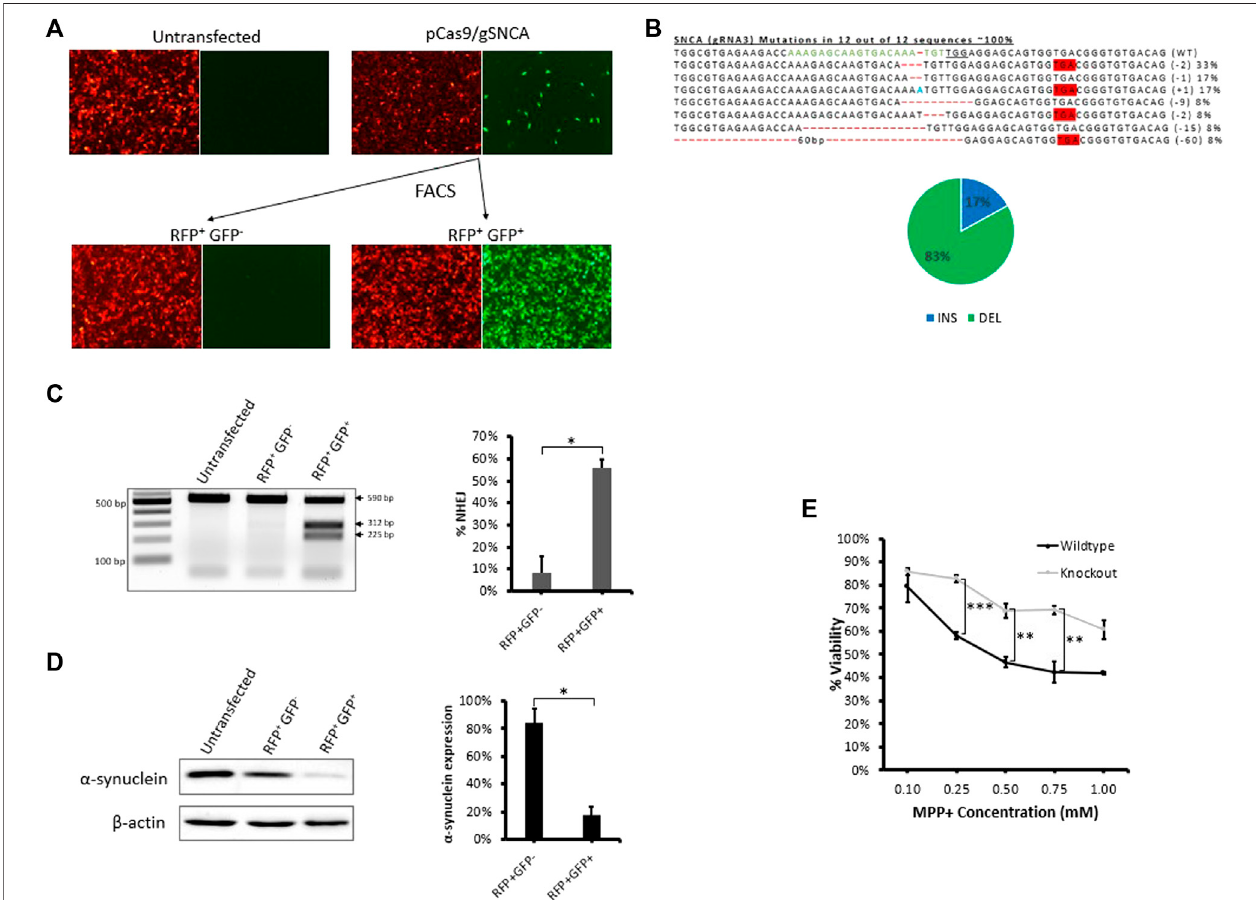
FIGURE 5 | Fluorescence assisted enrichment of knock-out SH-SY5Y cells. (A) Microscopy images of pre- and post-sorted fl uorescent reporter SH-SY5Y cells transfected with plasmid targeting SNCA gene. (B) Sanger ’ s sequencing of clones revealing CRISPR-induced indels and mutations. gRNA binding site (green) in the wildtype (WT) sequence is shown, the PAM sequence is underlined, dashes indicate deletions (-), nucleotides colored in blue indicate additions (+), and nucleotide colored in red indicate substitutions (s). Mutation frequencies (shown on the right) are calculated as the number of clones carrying a mutation divided by the total numberofclonessequenced.Mutationfrequenciesareillustratedinthepiechart:atotalof17%ofthemutationsleadtoinsertions,33%leadtodeletions,and67%lead to the formation of a premature stop codon. (C) T7E1 assay carried out on genomic DNA extracted from post-sorted RFP + GFP- and RFP + GFP + cells con fi rming the formation of indels in the target region. Quanti fi cation of indels in T7E1 is shown on the right. Values were background corrected from Untransfected group. Results are expressedasmean±standarderrorofthemeanof n =3fromT7E1assaycarriedoutongenomicDNAoftargetedcells.Therewasasigni fi cantdifferenceinfrequencyof indels (*, p < 0.05) between RFP + GFP − and RFP + GFP + groups, as analyzed by Student ’ s t -test. (D) Western blot evaluation of endogenous α -synuclein protein expression in post-sorted RFP + GFP − and RFP + GFP + cells. Quanti fi cation of protein expression in western blot is shown on the right. Results are expressed as mean ± standard error of the mean of n = 3 blots carried out on cell lysates of the same cells. There was a signi fi cant difference in protein expression (*, p < 0.05) between RFP + GFP − andRFP + GFP + groups,asanalyzedbyStudent ’ s t -test. (E) CytotoxicityMTTAssaycomparingcellularviabilityofSNCAwildtypereporterSH-SY5Ycellsand RFP + GFP + SNCA knock-out cells exposed to 1, 2.5, and 5 mM MPP + for 24 h. Results are expressed as mean ± standard error of the mean of n = 3. There was a signi fi cantdifferenceincellularviability(**, p < 0.01;***, p < 0.001)betweenSNCAwildtypereporterSH-SY5YcellsandRFP + GFP + SNCAknock-outcells,asanalysedby Student ’ s t